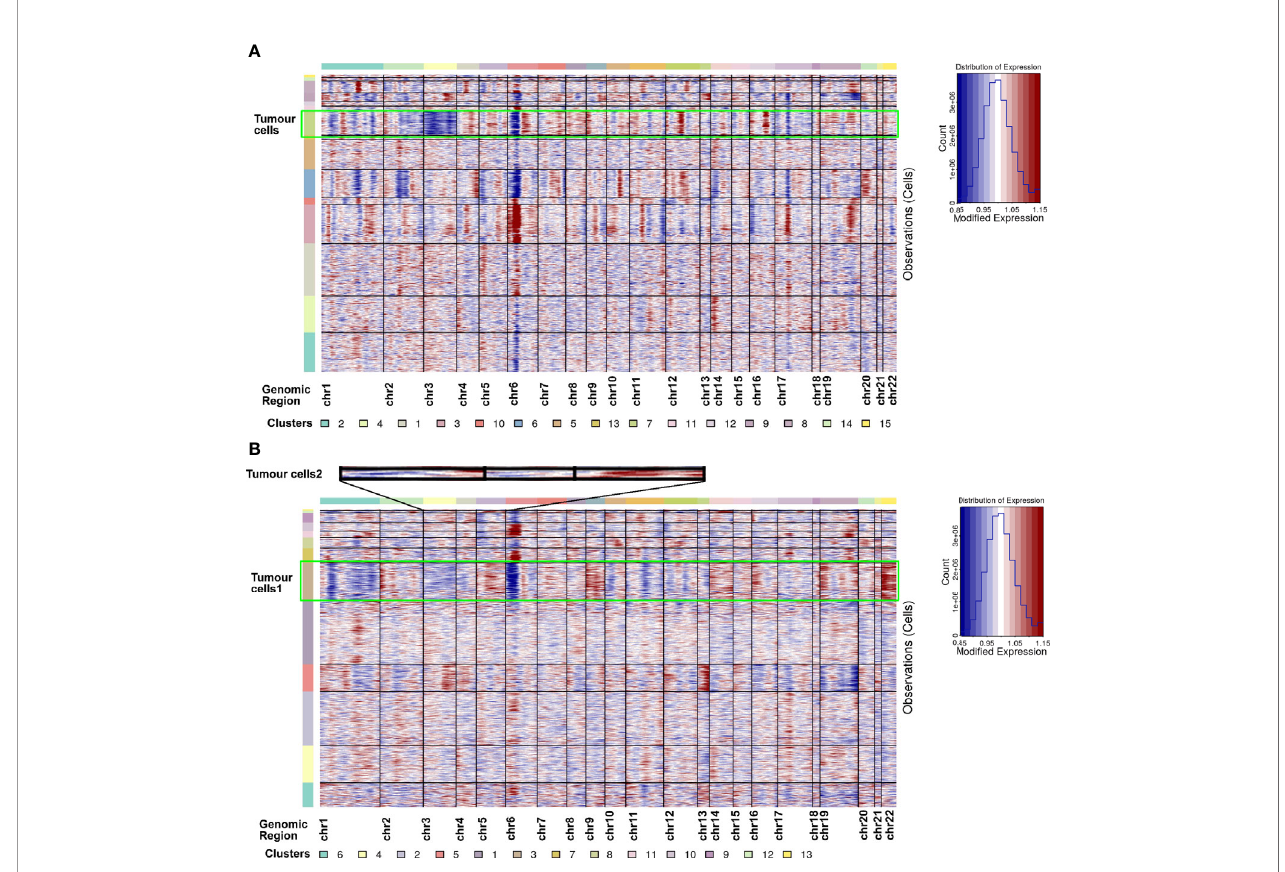
FIGURE 4 | CNV analysis for all cell types in ccRCC1 (A) and ccRCC2 (B) , respectively. Copy number gains (red) and losses